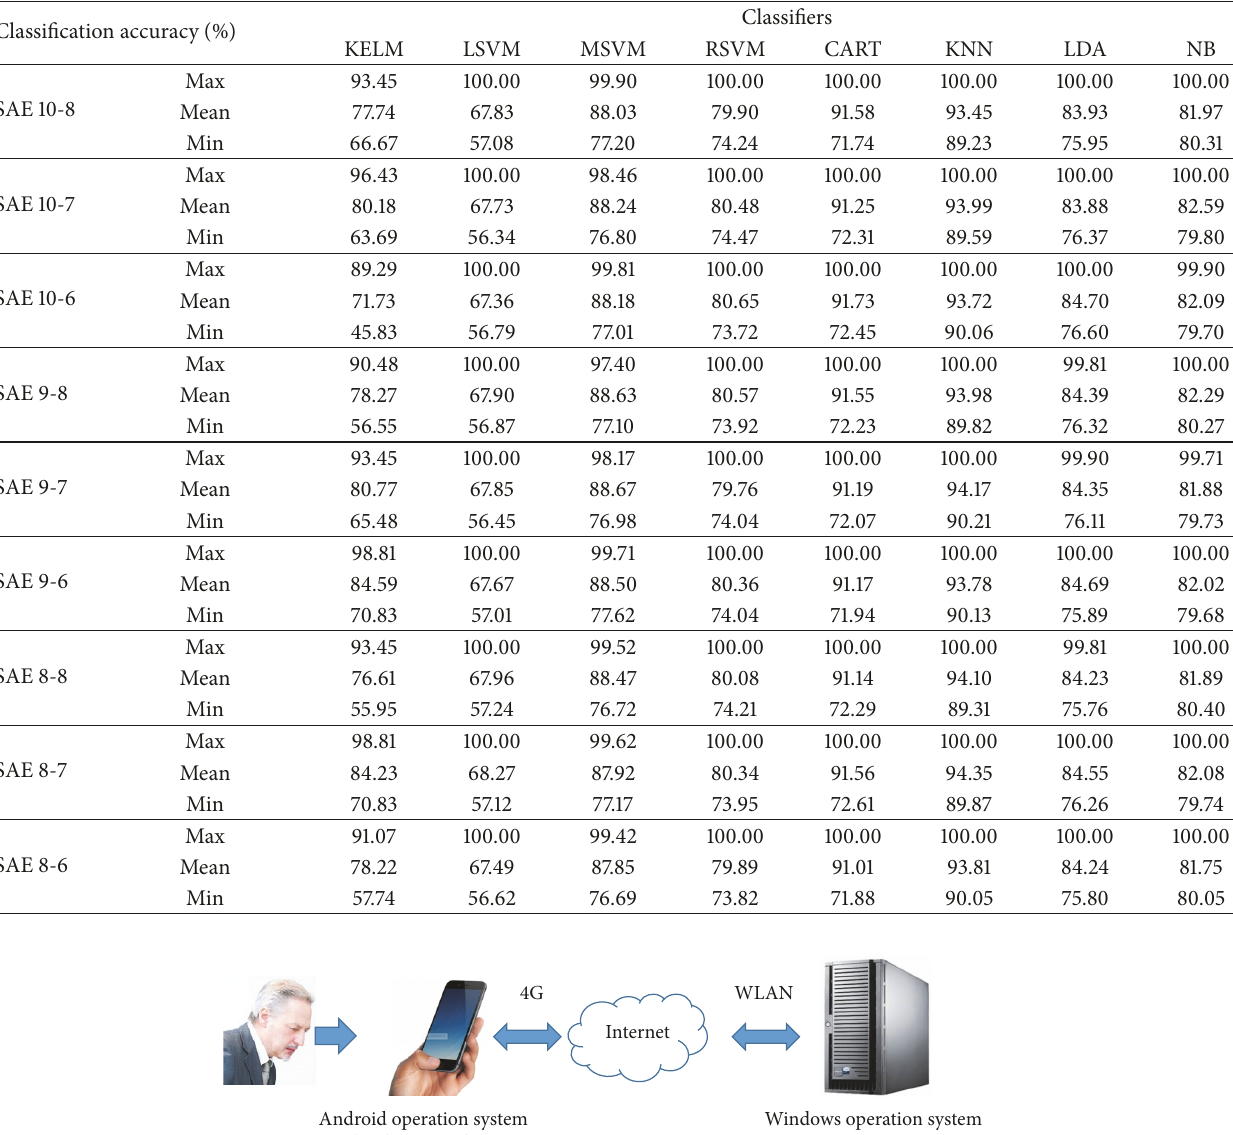
Table 7: Results of comparative classifiers with SAE on Istanbul Dataset.